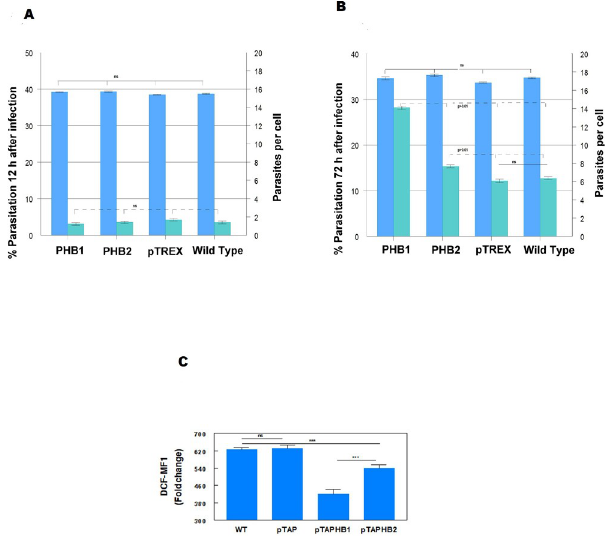
Fig 10. Overexpression of PHBs in different stages of T . cruzi . (A) Percentages of infection and percentage of infected Vero cells 12h post-infection with T . cruzi trypomastigotes: T . cruzi (pTAPHB1), T . cruzi (pTAPHB2), T . cruzi (pTAP) and T . cruzi wild-type. ( B ). Percentages of infection and percentage of infected Vero cells after 72 h with T . cruzi trypomastigotes: T . cruzi (pTAPHB1), T . cruzi (pTAPHB2), T . cruzi (pTAP) and T . cruzi wild-type. The percentages of infection and the number of amastigotes per cell were obtained by counting the infected cells and the number of amastigotes inside each cell. (C) Flow cytometry results of the effect of the H 2 O 2 treatment over the different parasite cell lines. I: measurements obtained comparing the fluorescence of the treated versus non-treated parasites. II: Ratio of the mean fluorescence intensity (MIF) of the treated versus the untreated samples. The Fisher LSD test p < 0.05 was applied to assess significant differences between the different parasite lines.